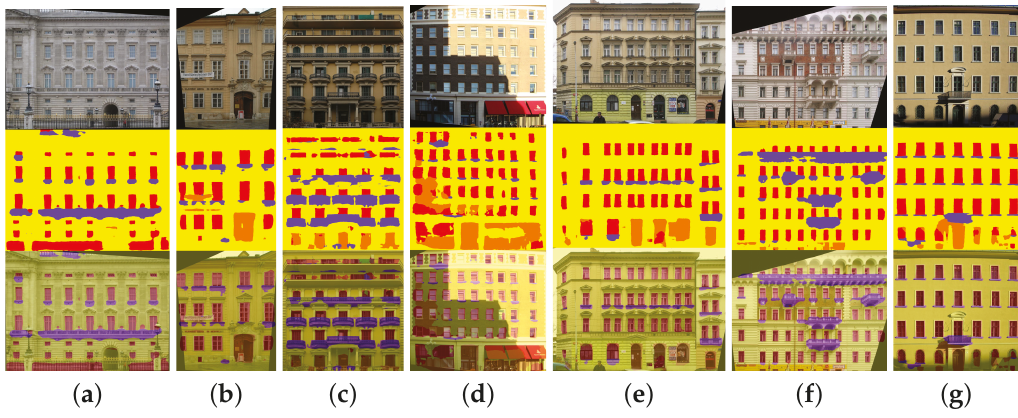
Figure 6. Results over the CMP dataset. ( a – g ) Example of CMP images, segmented by the neural model presented in Section 4.1.2. The three different rows correspond to the same description as in Figure 5.